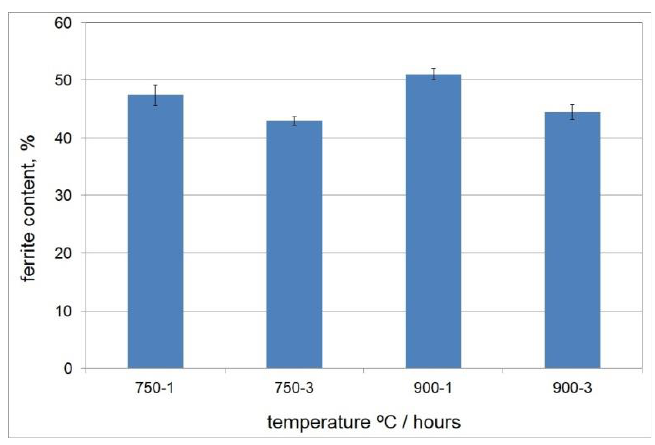
Figure 4. Effect of holding time and temperature on ferrite content in tested cast steel.